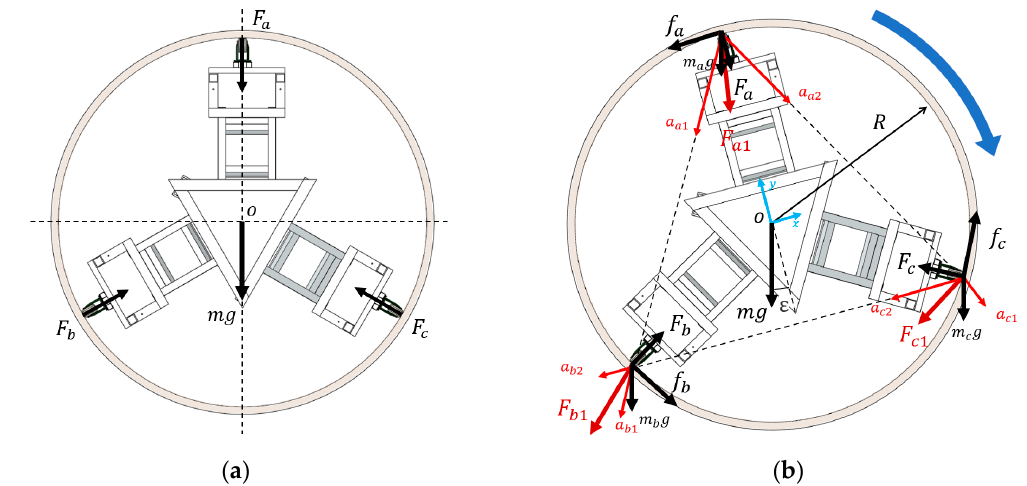
Figure 6. ( a ) Positive posture of the robot in the tube; ( b ) schematic of the force on the robot during differential motion (blue arrow represents the rotation direction).